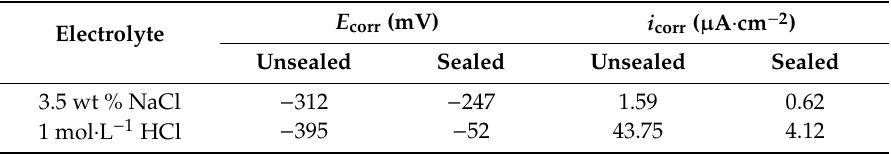
Table 2. Corrosion current densities ( i corr ) and potentials ( E corr ) obtained from the potentiodynamic polarization curves of unsealed and sealed nanostructured WC-CoCr coatings in 3.5 wt % NaCl and 1 mol · L − 1